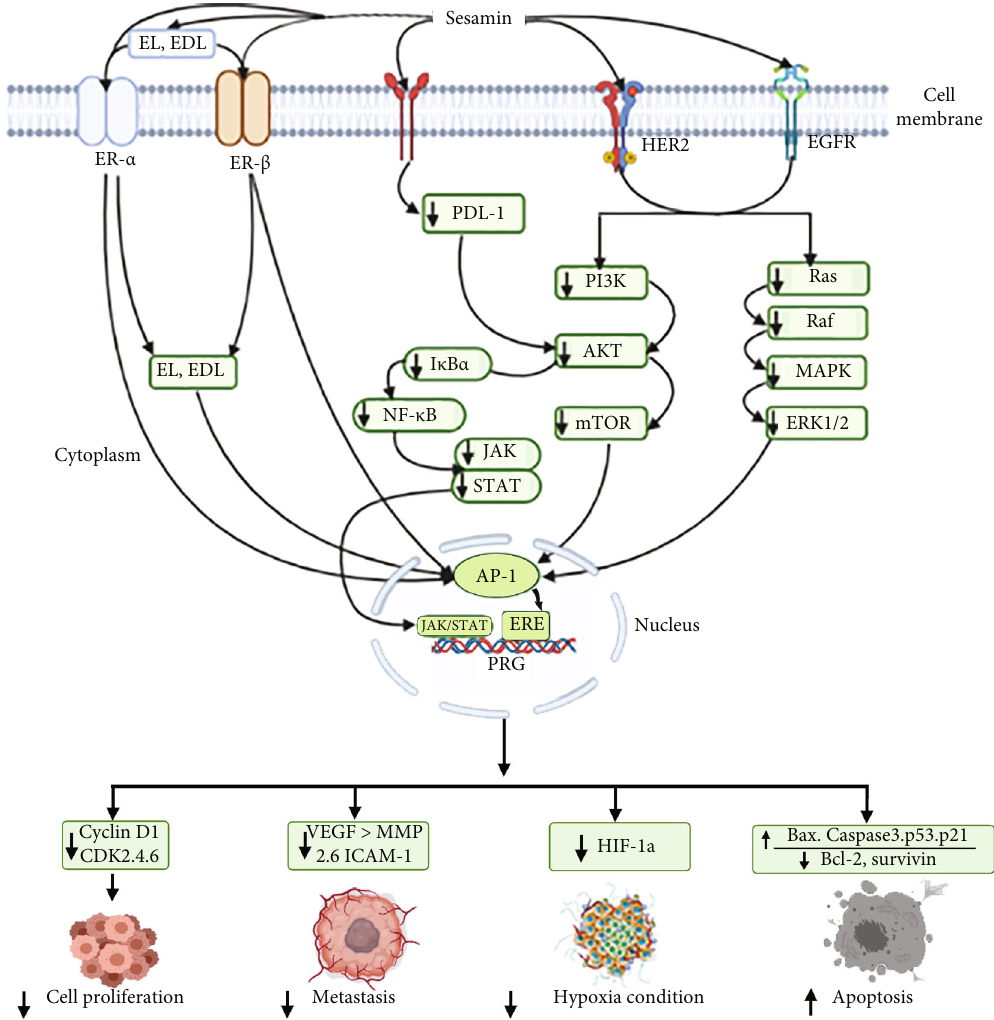
Figure 2: Graphical presentation of the molecular pharmacology of sesamin in breast cancer. Sesamin and its metabolites have potential antibreast cancer activities. In the early stage, the mechanism is mediated through regulation of extracellular receptor-like estrogen receptor- α (ER- α ), estrogen receptor- β (ER- β ), programmed death-ligand 1 (PD-L1), Herceptin epidermal growth receptor 2 (HER-2), and epidermal growth factor receptor (EGFR). Through this receptor, sesamin and its metabolites inhibit some major signaling molecules like pAkt-PI3K/mTOR and JAK/STAT. These tumor intrinsic signals upregulate activator protein 1 (AP-1), inhibit estrogen- responsive elements (ERE), and activate other regulatory proteins. Sesamin and metabolites fi nally inhibit cell cycle progression by the suppression of cyclin and its associated enzyme kinase (CKD 2, 4, and 6); inhibit metastasis and angiogenesis by the suppression of MMP 2, MMP 9, ICAM-1, and VEGF; and induce apoptosis by the upregulation of Bax, caspase 3, P 21 , and P 53 with downregulation of Bcl2 and survivin